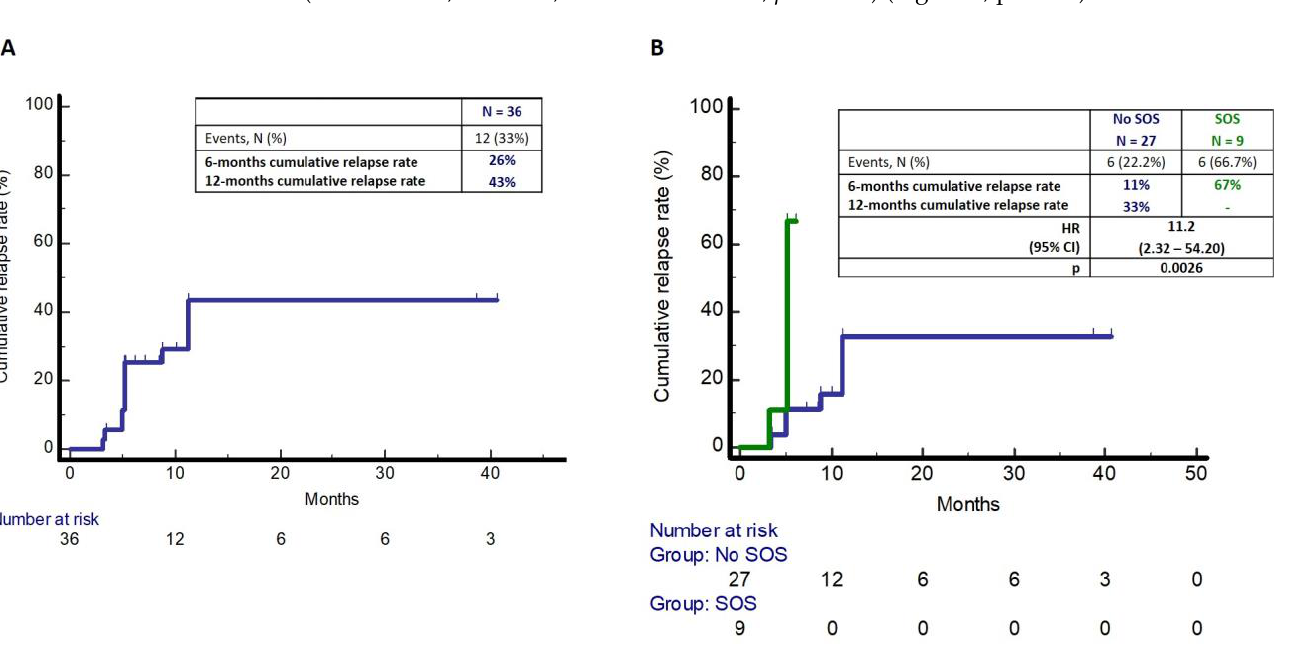
Figure 3. A 53-year-old male who had an RTLM and SRLM after chemotherapy. Two liver metasta- ses in segment V sized 32 mm and 12 mm (white and red arrows, respectively) were identified on diffusion-weighted ( a ) and hepatobiliary phase ( b ) images of baseline MRI. After chemotherapy, the size of the bigger metastasis decreased to 9 mm (white arrow), whereas the smaller one became visible (red arrow) only on diffusion-weighted imaging ( c ) but not on hepatobiliary phase image ( d ) of follow-up MRI.